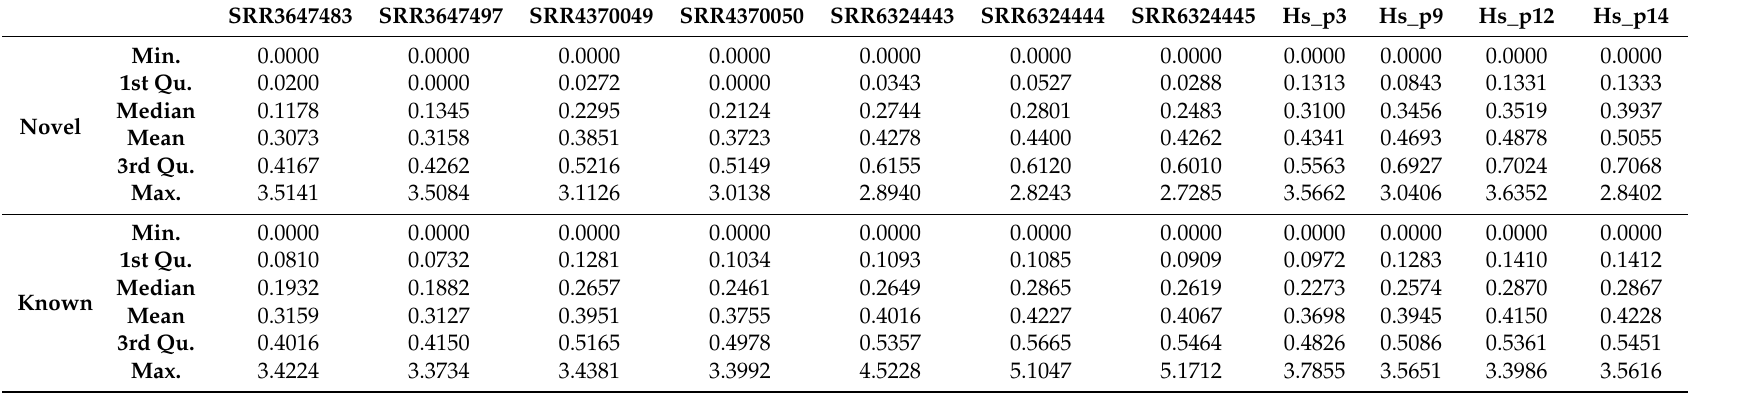
Table 3. Summary statistics of logarithm FPKM values for novel and known lncRNAs in external data and our